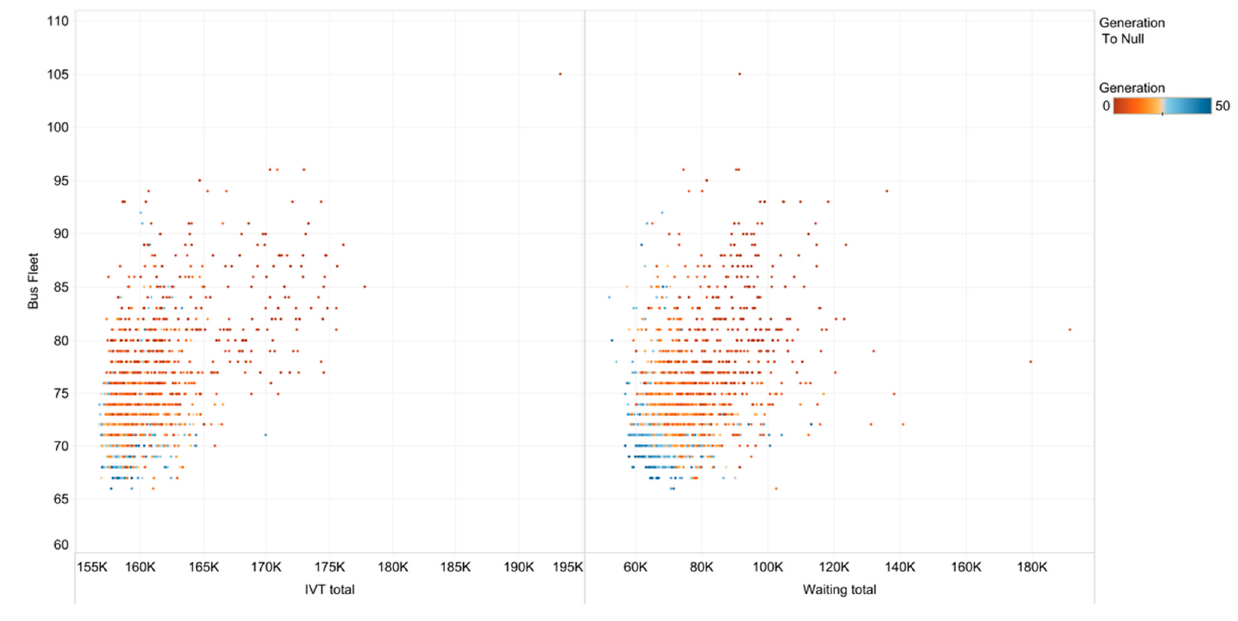
Figure 5. In-vehicle & Waiting times per solution per generation (color signifies generation).